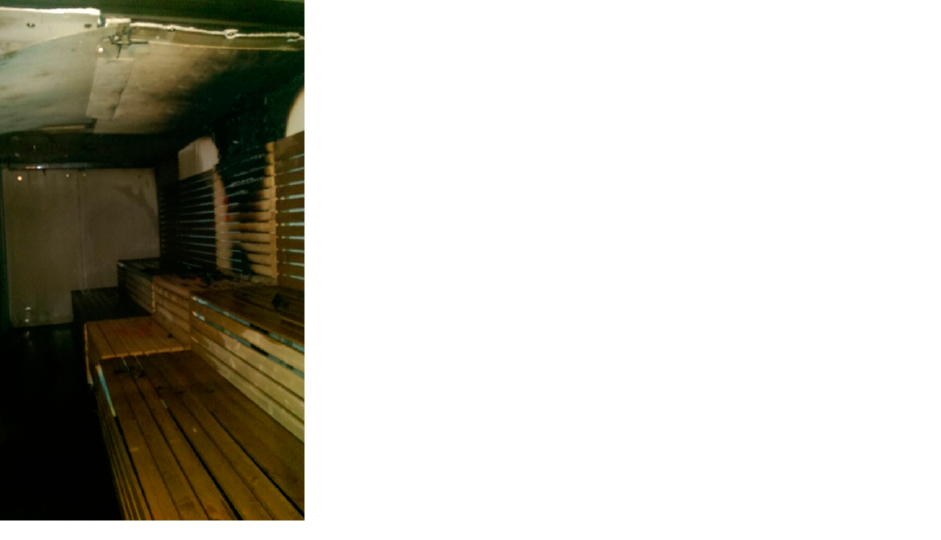
Figure 12. Bench and plywood boards at the ceiling and against the walls at the end of Test no. 7.